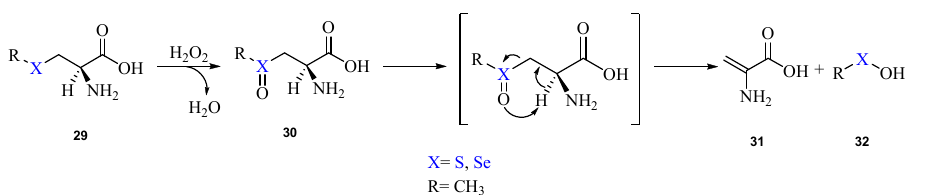
Table 5. Gibbs free energies ( ∆ G, kcal/mol) relative to the free reactants for the oxidation and sequential β -elimination of MeCys and MeSec in water. Activation and reaction Gibbs free energies are relative to RC ox for the oxidative step and to P ox for the elimination. Level of theory: Figure 4. Stationary points along the oxidation mechanism of MeCys/MeSec by H 2 O 2 (see Scheme 14) and subsequent elimination. Adapted from [90].